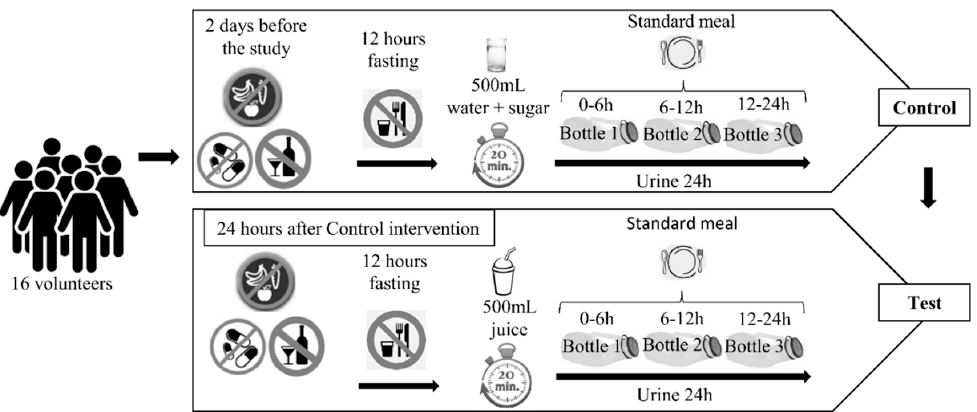
Figure 1. Study design. Sixteen healthy male volunteers were recruited and instructed to follow